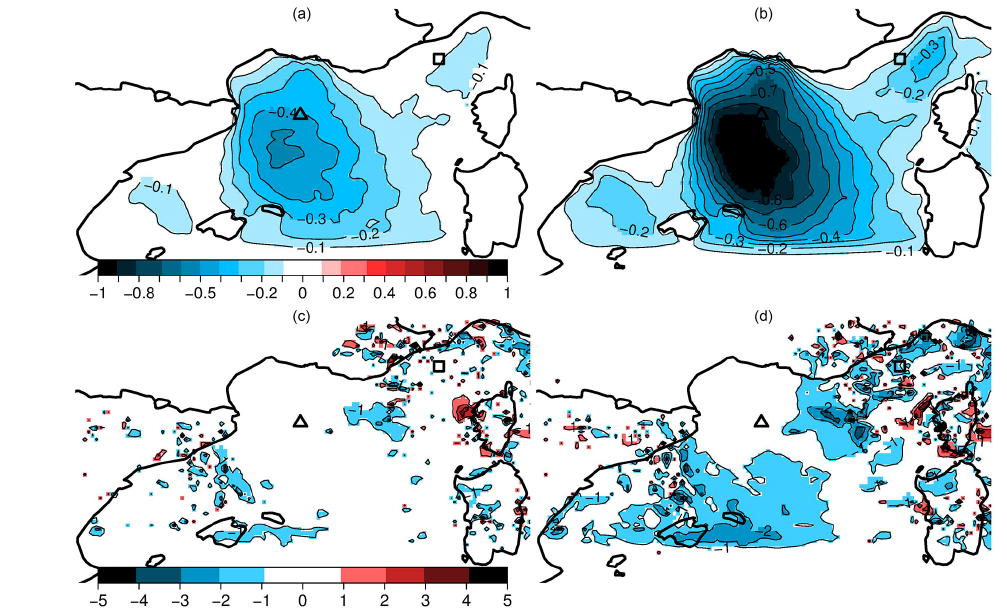
Figure 4. 10m wind speed bias [ms − 1 ] (a, b) and 10m wind direction bias [ ◦ ] (c, d) for α = 0 . 025 (a, c) and α = 0 . 05 (b, d) with respect to reference ( α = 0 . 0123). Locations of Lion (triangle) and Azur (square) buoys.